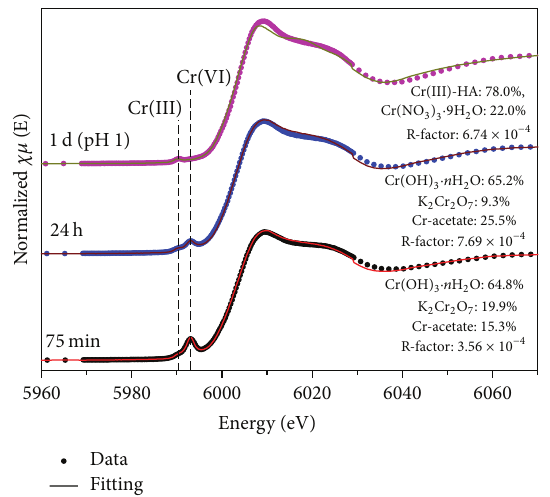
Figure 5: Cr K-edge XANES spectra (dashed lines) and the results of linear combination fitting (solid lines) for the precipitates collected from the reactive products of 105 mg L −1 Cr(VI) with 200 or 400 mg L −1 H 2 Q at pH 3.0 and 25 ∘ C for 75 min and 24 h. The spectrum of the precipitates obtained from the 1d (pH 1) sample was also shown. The spectra of the reference materials of K 2 Cr 2 O 7 , Cr(OH) 3 ⋅ n H 2 O, Cr-acetate, Cr(NO 3 ) 3 ⋅ 9H 2 O, and Cr(III)-HA were used for calculation during linear combination